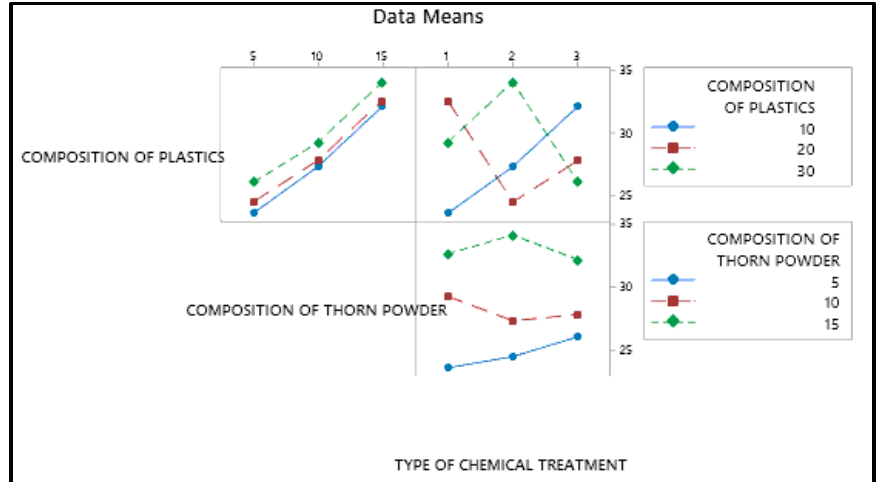
Figure 2. Interaction plot for SN ratios for Hardness.